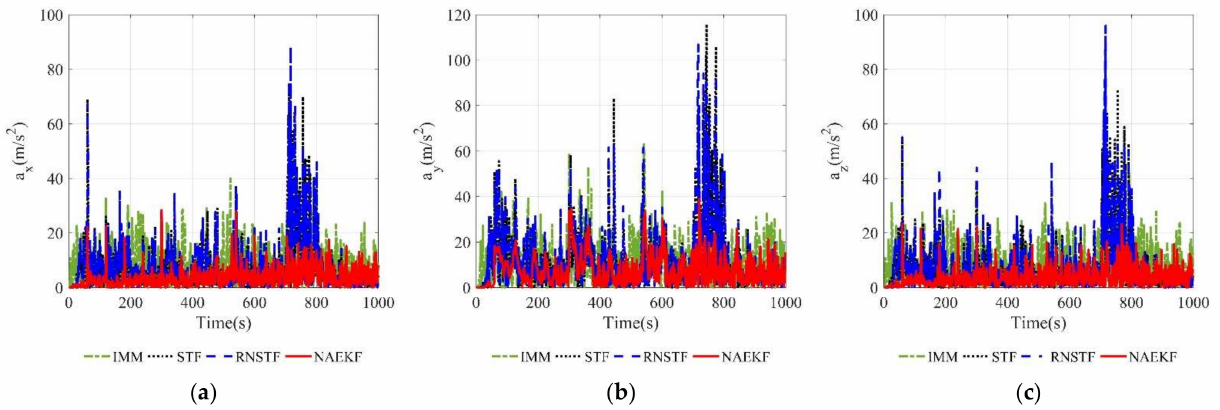
Figure 23. Acceleration estimation errors. ( a ) Estimation errors of a x ; ( b ) Estimation errors of a y ; ( c ) Estimation errors of a z .